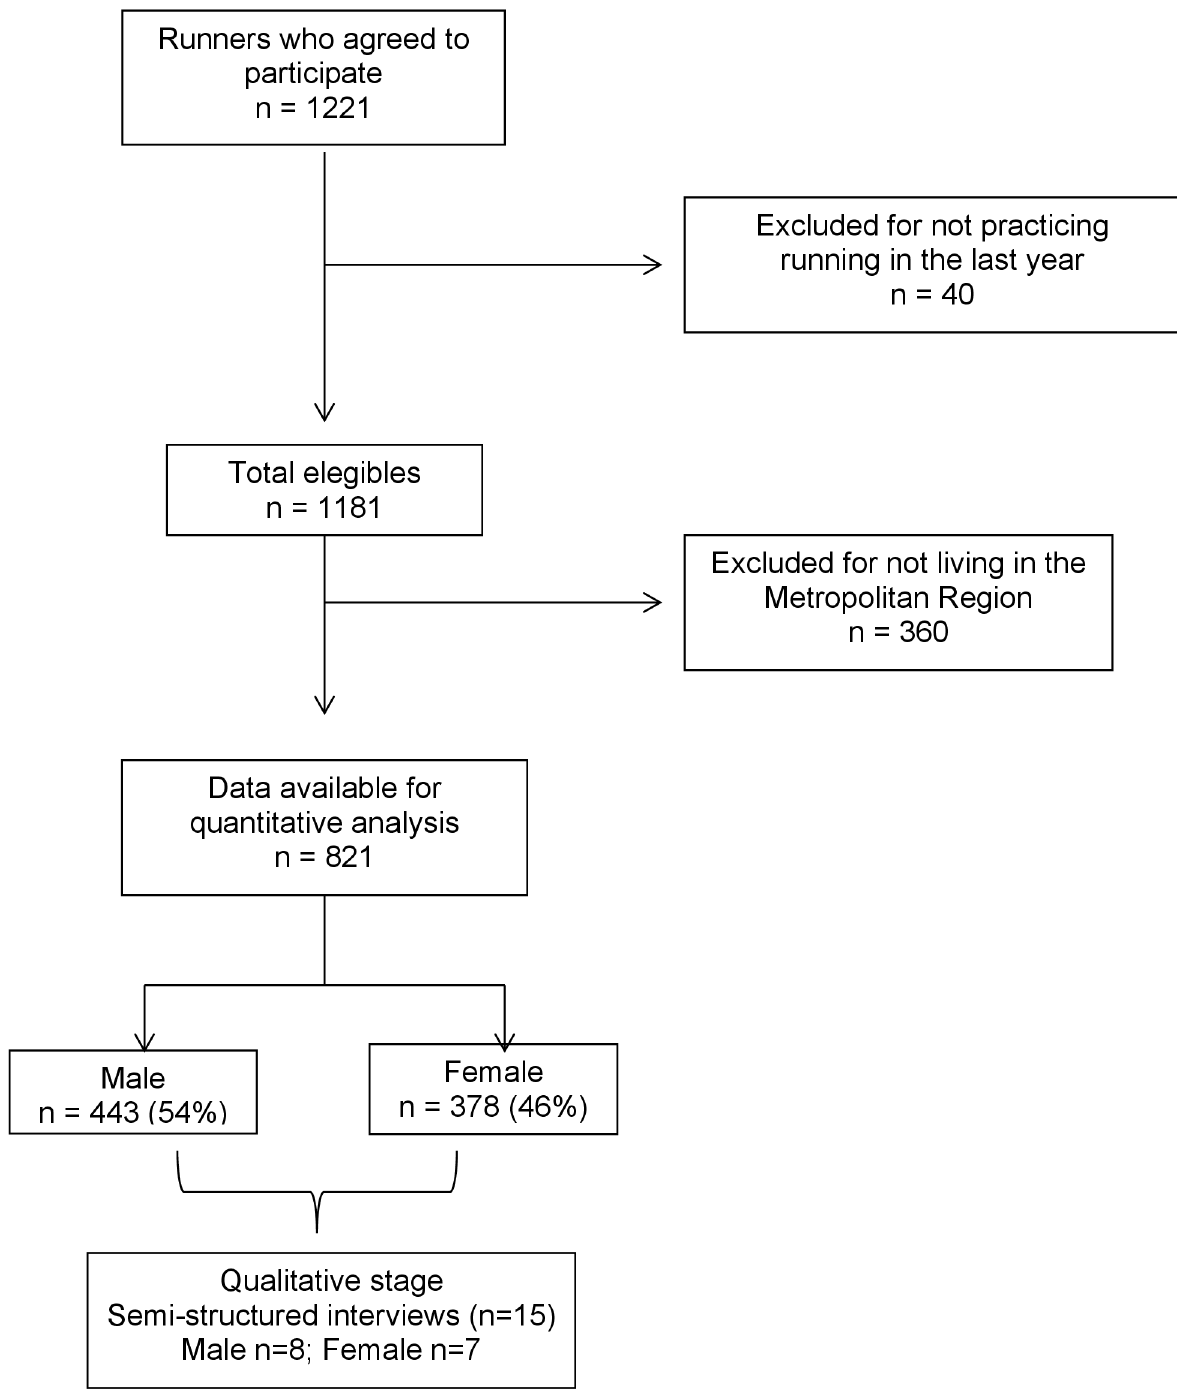
Fig 1. Flowchart of the participant recruitment and selection